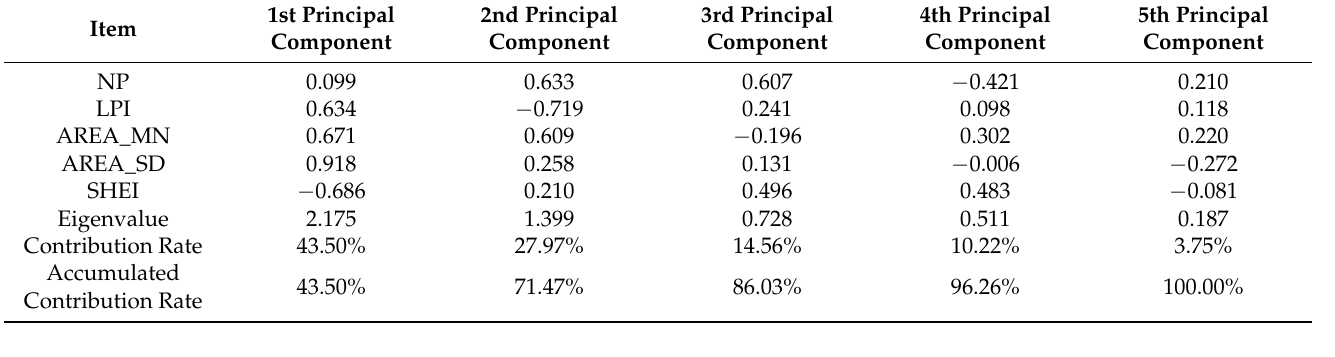
Table 6. Principal component analysis of color pattern metrics of the Cotinus coggygria var. cinerea Engl. forest.